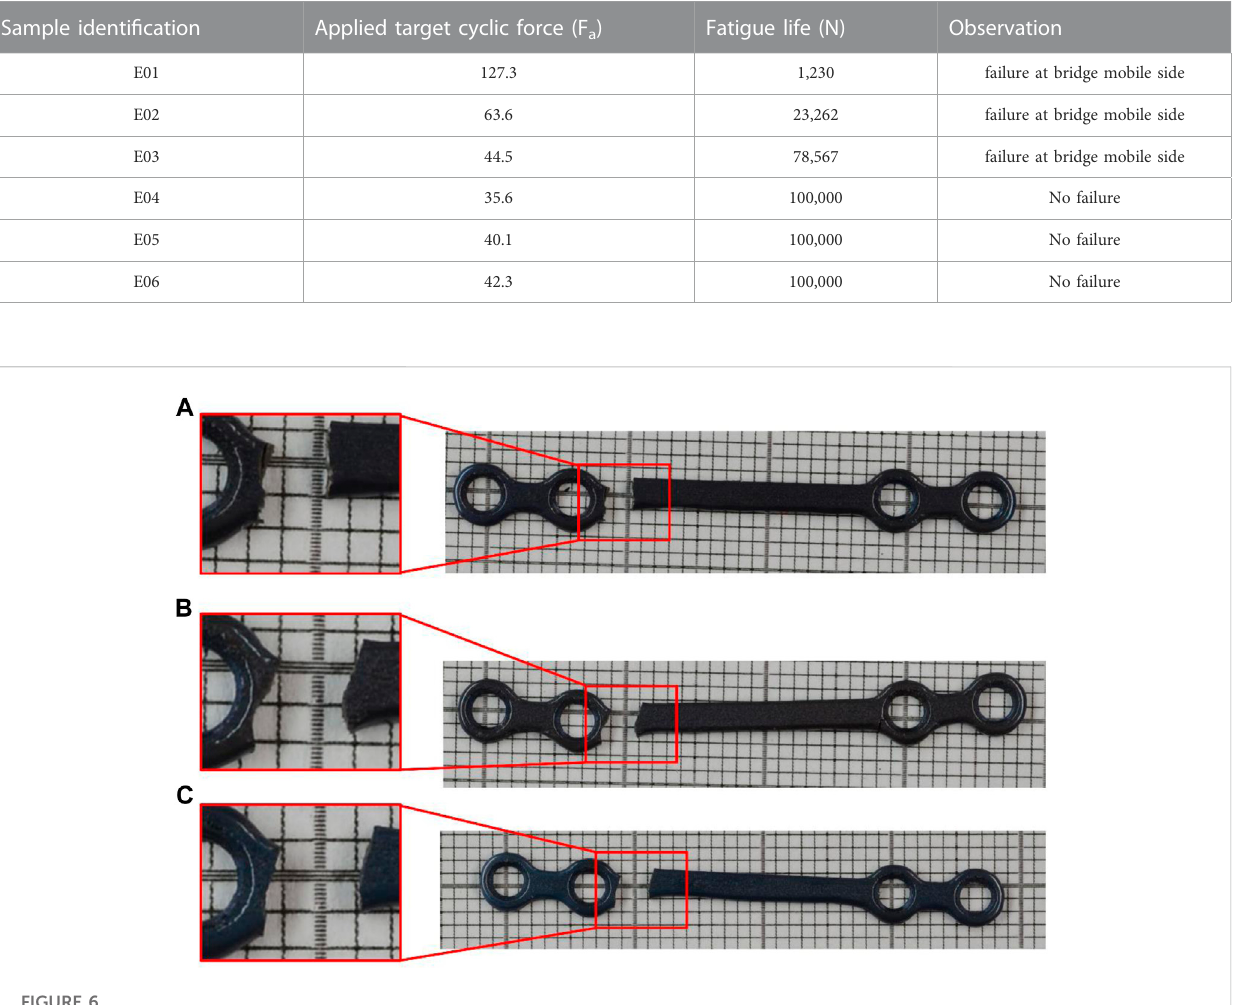
FIGURE 6 Failure pro fi le of the osteosynthesis plates. (A) : sample E01 with 127.3 N applied cyclic Force, (B) : sample E02 with 63.6 N applied cyclic Force, and (C) : sample E03 with 44.5 N applied cyclic Force.